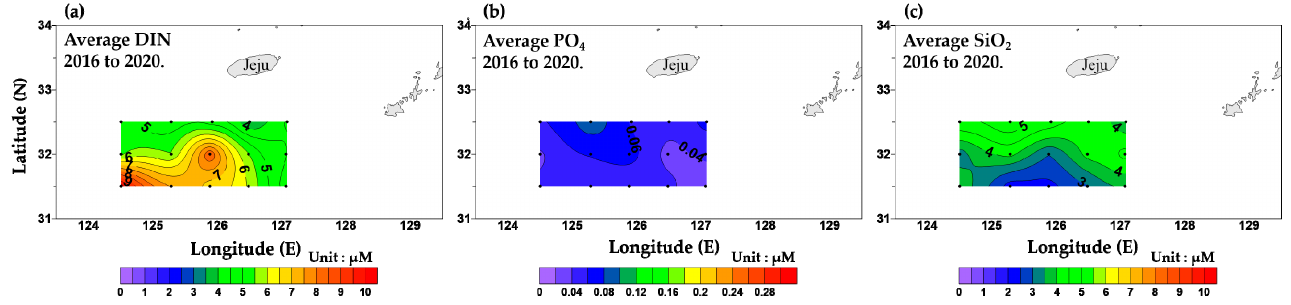
Figure 5. Spatial distributions of average surface dissolved inorganic nitrogen ( a , DIN), PO 4 ( b ), and SiO 2 ( c ) concentrations (in µM) in the northern East China Sea from 2016 to 2020.